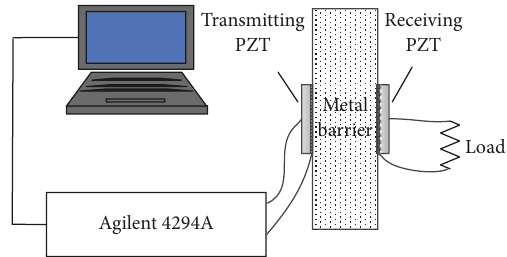
Figure 8: Experimental setup for measuring the input impedance of an acoustic-electric channel.